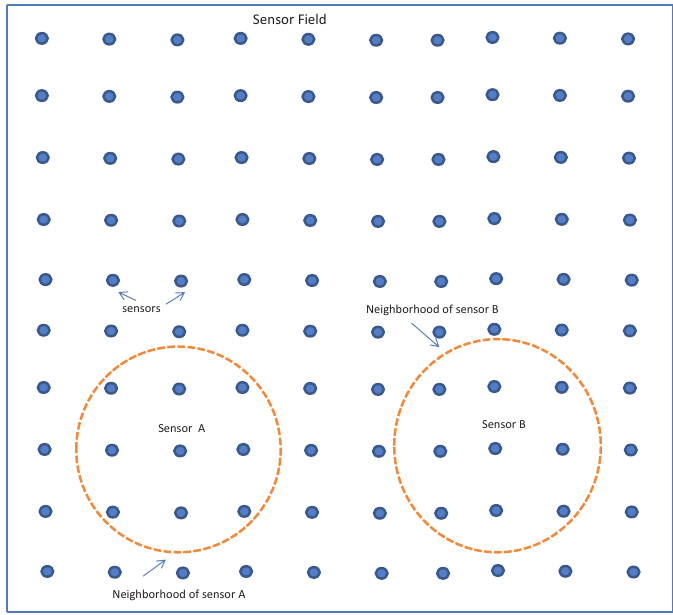
Figure 1. Sensor network